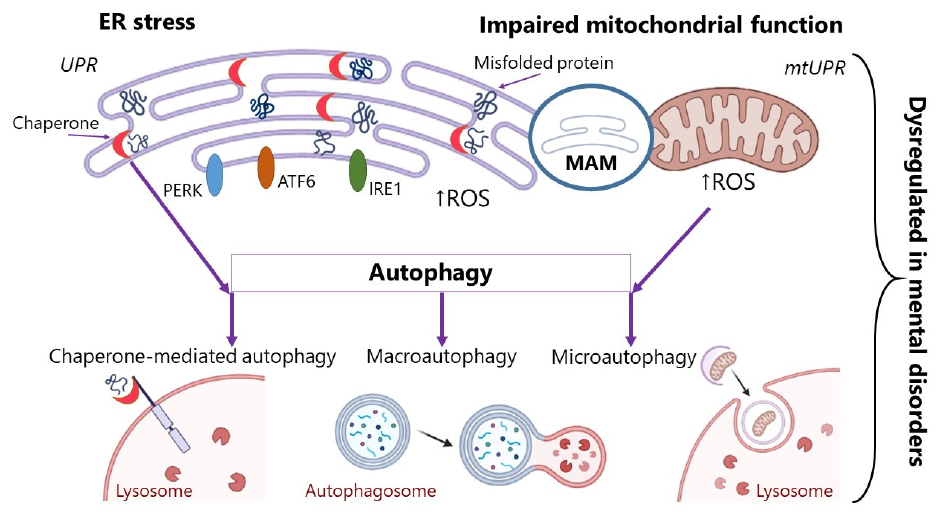
Figure 1. Mechanisms of impaired post-translational modification of proteins: (1) ER stress. The EP response to stress is regulated by three effectors inositol-requiring kinase-1 (IRE1), protein kinase RNA-like endoplasmic reticulum kinase (PERK), and the activating transcription factor-6 (ATF6). ER has its own protein quality control system, unfolded protein response (UPR); (2) disruption in the chaperone proteins involved in folding proteins; (3) impaired mitochondrial function. Mitochondria have their own protein quality control system, unfolded protein response (mtUPR); (4) disruption of autophagy processes. MAM—mitochondria-associated membrane; ROS—reactive oxygen